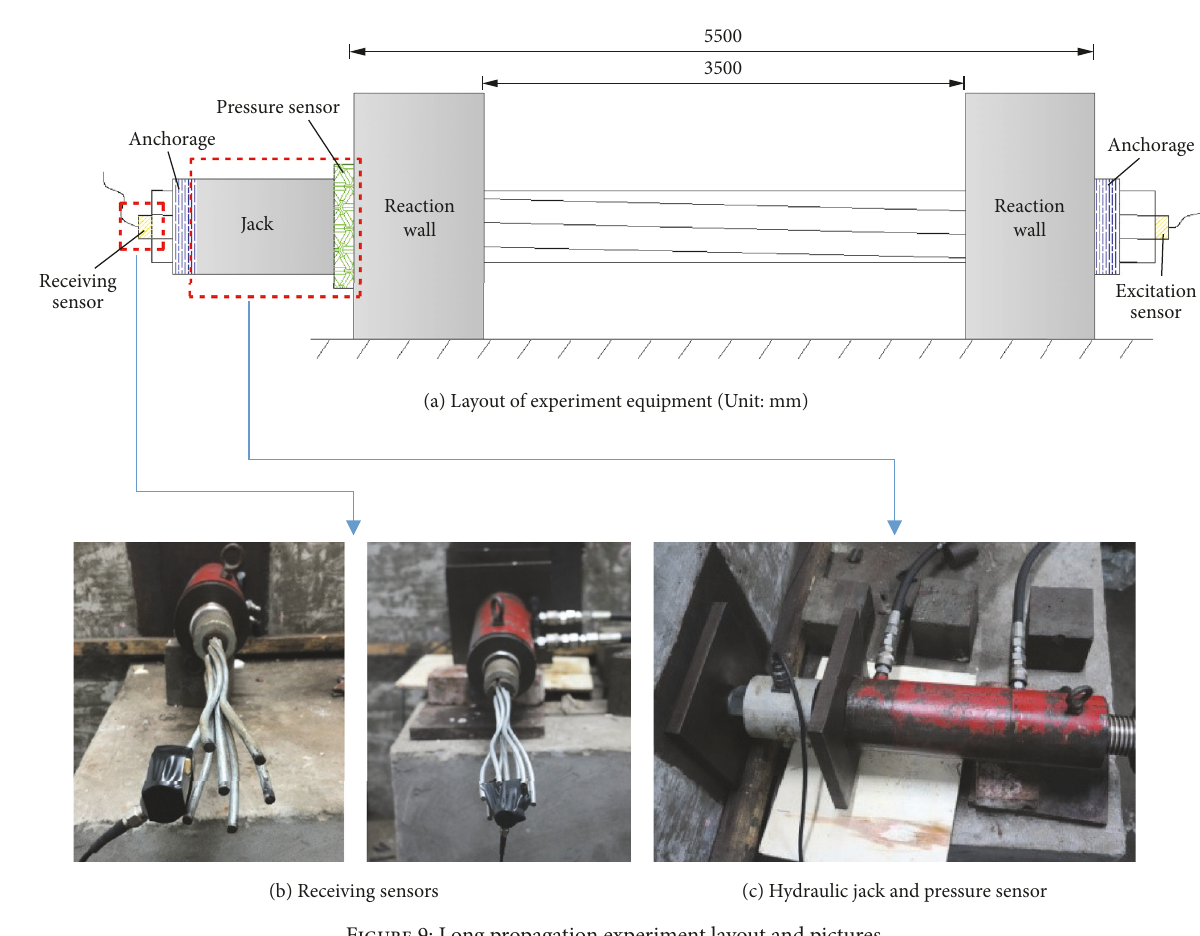
Figure 9: Long propagation experiment layout and